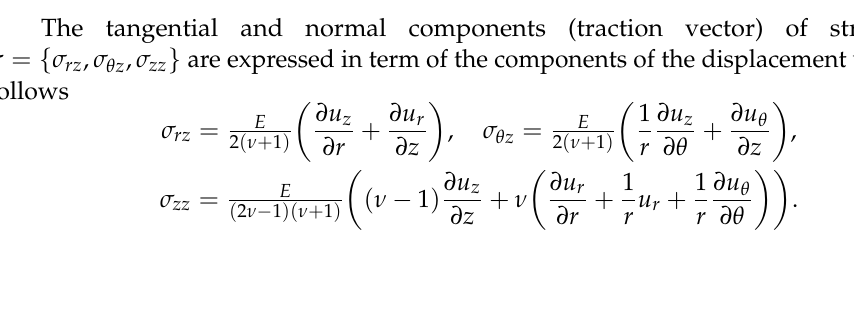
Figure 1. Statement of the